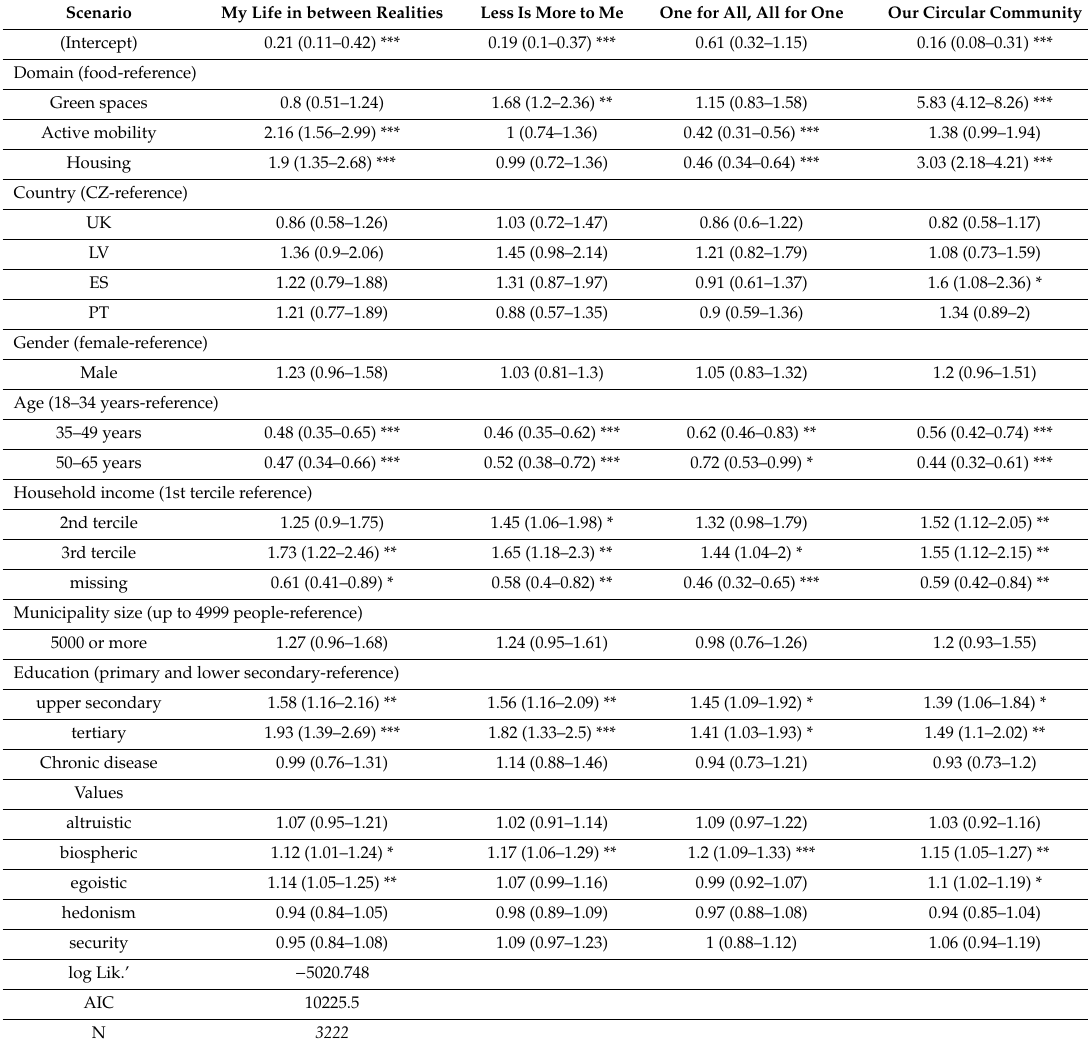
Table 2. Support for healthier, more equitable and more sustainable future scenarios—multinomial logit model, adjusted odds ratios 1